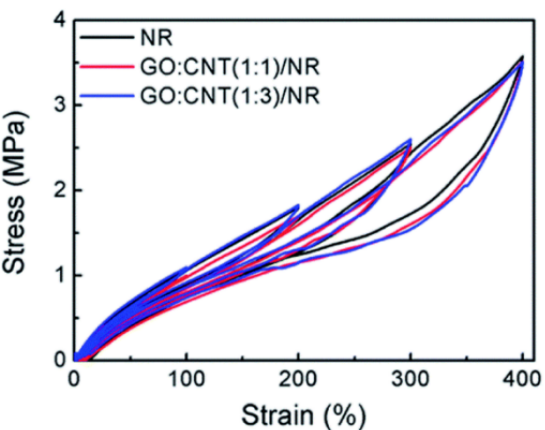
Figure 2. Hybrid filler–filled cyclic hysteresis curves of NR at various strains [29].